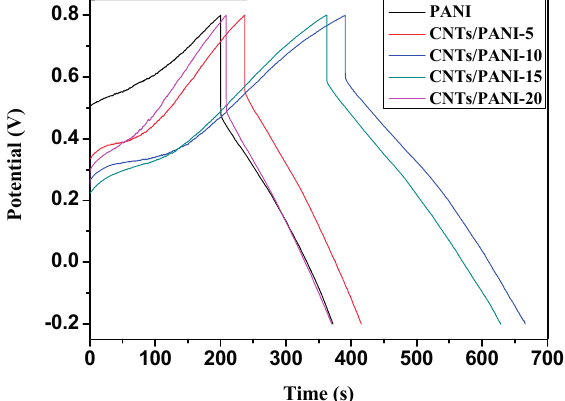
Figure 6. Galvanostatic charge/discharge (GCD) curves of the C-CNTs/PANI composite electrodes at a current density of 1 A/g in 1.0 M H 2 SO 4